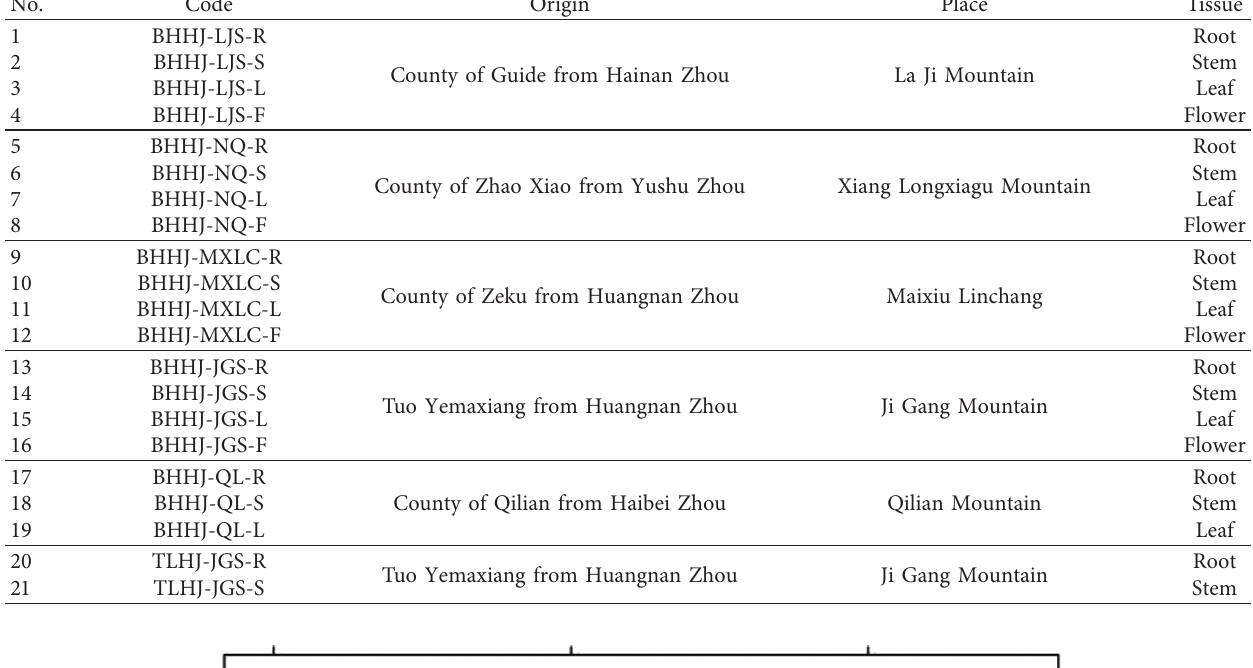
Table 1: Specific information of collected samples from Corydalis conspersa and Corydalis linarioides .